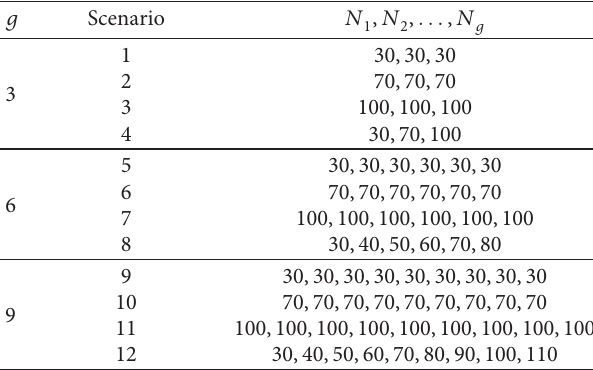
Table 2: Scenarios of